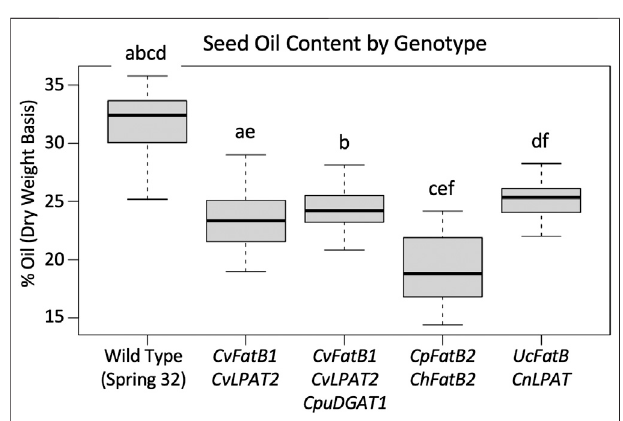
FIGURE 3 | Comparison of seed oil (TAGs) amounts in T3-generation seedsofthevarious transgenicMCFA-producinglinesvs.eachotherandwild type. The data is presented as percent oil per seed on a dry-weight basis. Solid bars in the Box Plots represent each median, gray boxes demarcate the upper and lower quartile, horizontal lines connected by the dotted lines represent the maximum and minimum. Box Plots with the same letter abovehavemeansthataresigni fi cantlydifferent( p < 0.05asdetermined by one-way ANOVA followed by Tukey ’ s HSD test). N (cid:1) seeds samples from 14 to 28 plants, with those plants representative of the two to four transgenic events. See Supplementary Figure S5 for the seed oil percentages for plants from each transgenic event graphed